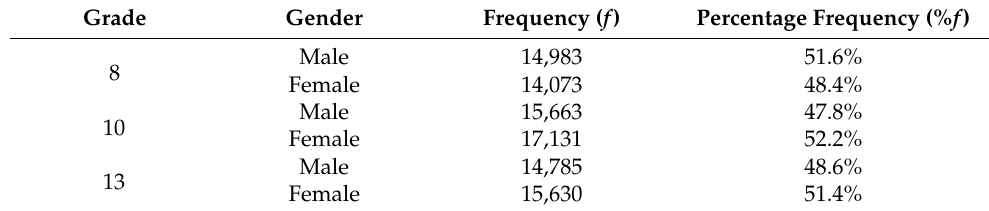
Table 2. The distribution of gender in the three